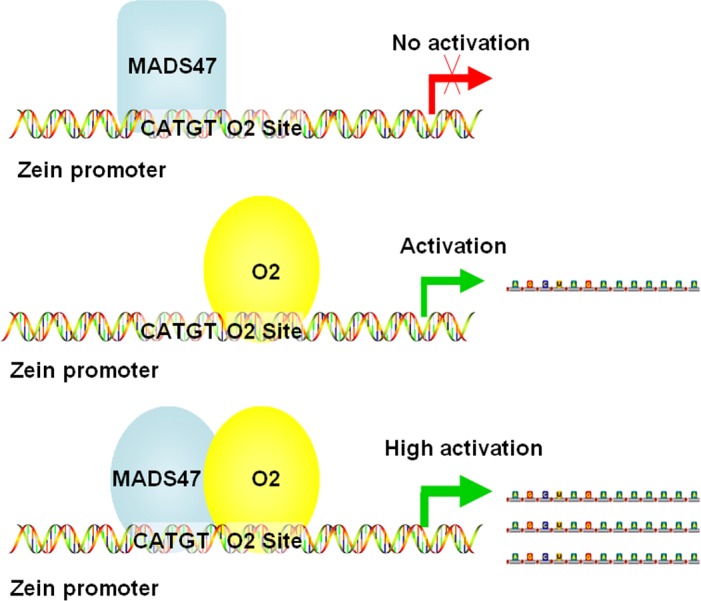
Illustrtion of how the O2/ZmMADS47 complex may regulate zein gene expression.The upper illustration shows ZmMADS47 alone (square) binds the CATGT motif but does not induce transactivation. The middle illustration shows O2 binding is able to transactivate its targets. The bottom illustration shows ZmMADS47 (oval) and O2 bind their respective motifs and the O2/ZmMADS47 complex enhances transactivation of gene targets.